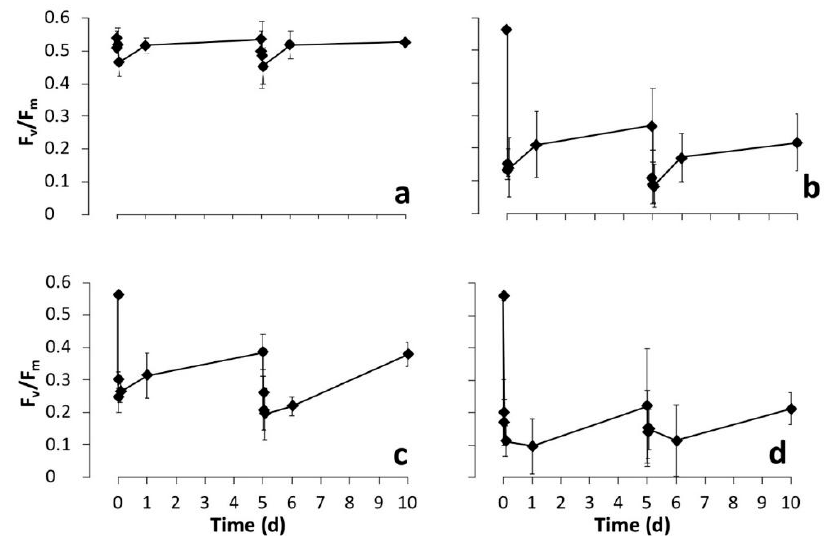
Figure 4. Changes over time of photosynthetic yield (F v /F m ) of cultured biofilms treated at days 0 and 5 with diverse phyto-derivatives, ( a ) control (CTRL), ( b ) lavender essential oil ( Lavandula angustifolia Mill.) (LAV), ( c ) liquorice alcoholic leaf extract ( Glycyrrhiza glabra L.) (LIQ) at 10% and ( d ) 30%. After each treatment measurements were made immediately, then at 5, 30 and 90 min, 1 and 5 days (10 days in total).